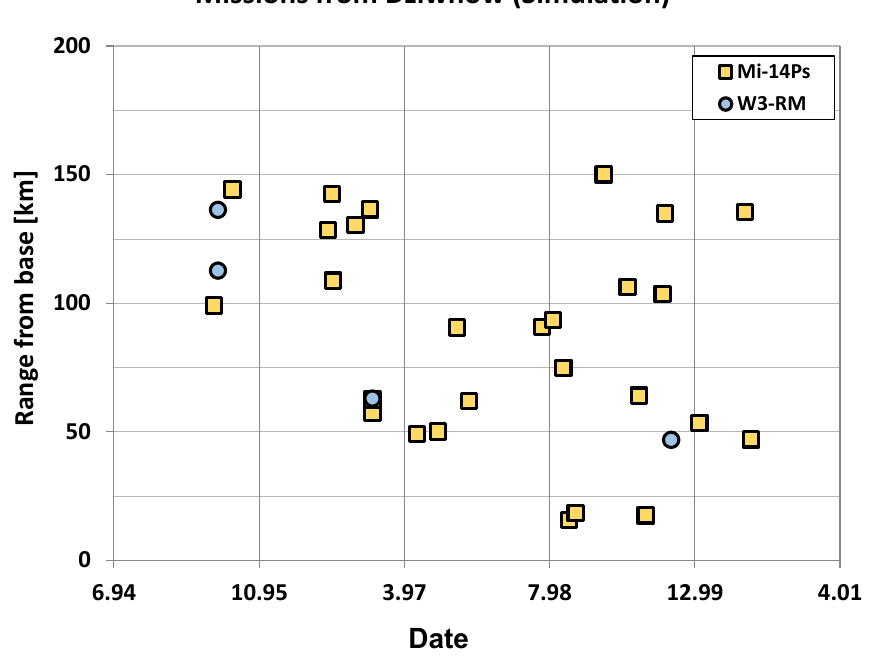
Figure 8. Range from base for simulated missions closer than 150 km which started from Dziwnów base in years 1995–2001; W3-RM and Mi-13PS helicopters were used.